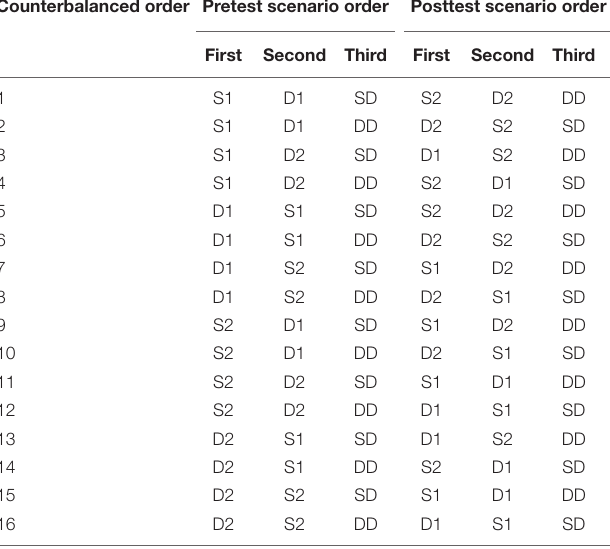
TABLE 3 | The 16 possible variations of scenario orders (S1/2 = shoot scenario; D1/2 = don’t-shoot scenario; SD/DD = shoot and don’t-shoot